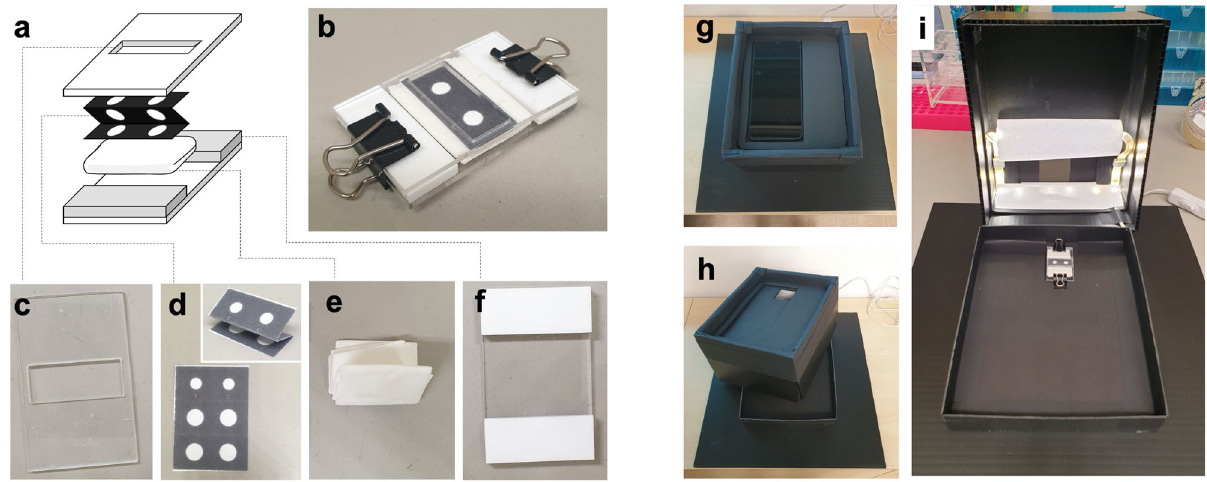
Fig. 1 Overview of the test construction and image acquiring devices. a Exploded scheme of the cellulose testing unit, comprising 2 pieces of acrylic manifold to hold the testing unit together, 3 layers of the folded and printed cellulose test strip whereby hydrophobic ink (black area) was used to determine liquid fl ow path and folded Kim Wipes which is used as an absorbent pad. b An Image of the assembled cellulose testing unit which is held together using paper binders. c An image the top piece of the acrylic manifold which contains an opening to access the cellulose test strip. d An image of cellulose test strip. The strip was printed and cut as one piece. Wax ink was used for printing (black area) to de fi ne the liquid fl ow path. To create 3 layers of the test strip, the printed paper is folded in a zig-zag motion until the hydrophobic regions are aligned (inset). The top most layer of the cellulose paper contains a circular testing region (white, hydrophilic area without ink) with a diameter of 5 mm whereas the lower two layers, each, contain hydrophilic regions with a diameter of 6 mm. Each cellulose testing unit contains two test zones for testing of two reactions. e An image of the folded Kim Wipes which was folded in half for 6 times and used as absorbent material. f An image of the lower piece of the acrylic manifold which contain 3 mm spacers at two ends. The spacers are used to control consistent pressure that applies to different cellulose testing units. g An image of the light box with the phone placed at the top face. h An image of a slight opened light box showing phone fi xture and a void for phone camera access at the top face. i An image of opened light box showing internal structure of the box. Warm-white LED light strips were attached to the inner top face of the light box to provide consistent lighting for all images. Cylindrical, white papers were covered parts of the LED strips to diffuse light from the strip, prevent shadow which may form on the cellulose test unit. Fixture was placed at the base of the light box to provide a fi xed location to place the cellulose test